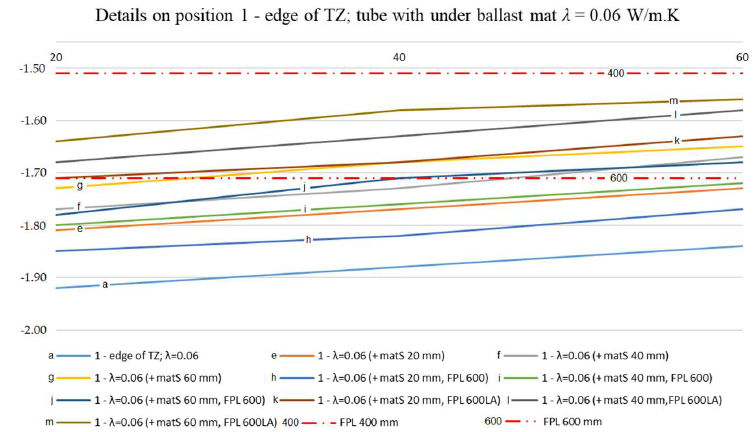
Figure 11. Detail of optimization to eliminate the frost transition through structural layers of TZ with matA + matS .